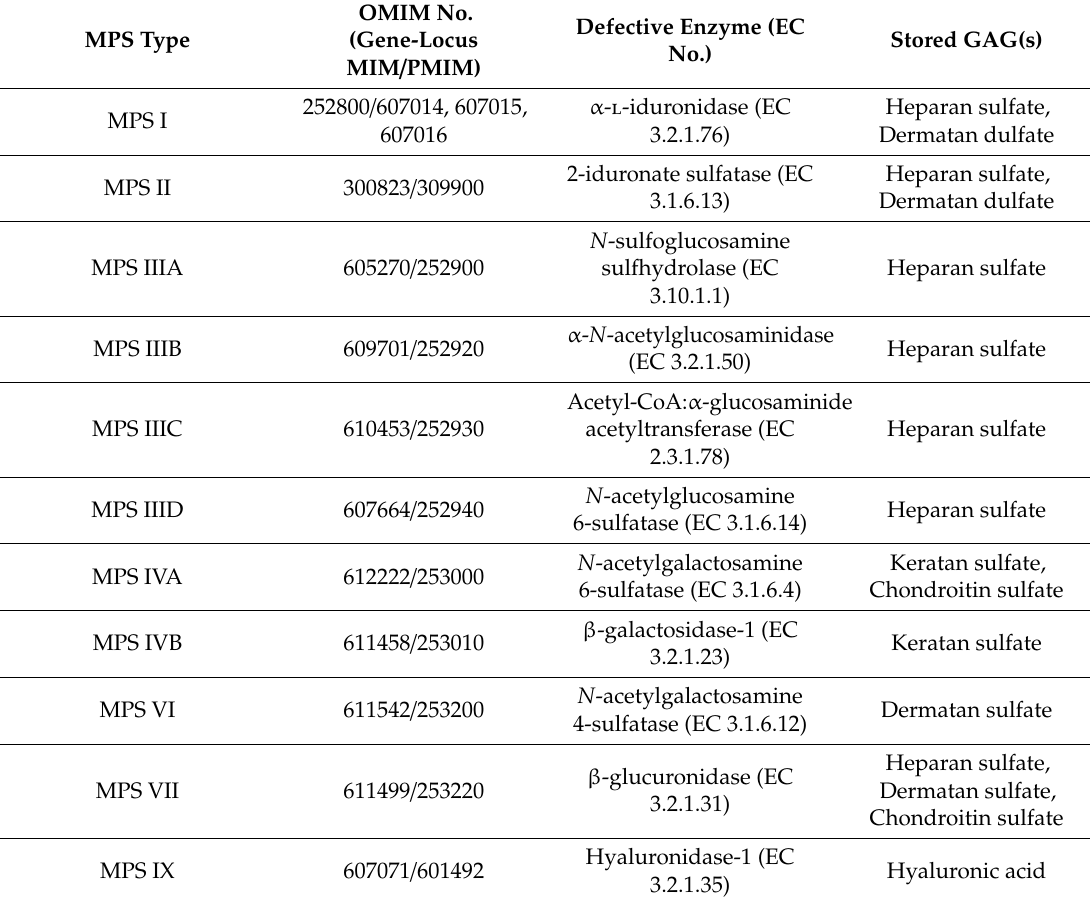
Table 1. Types and subtypes of MPS (based on